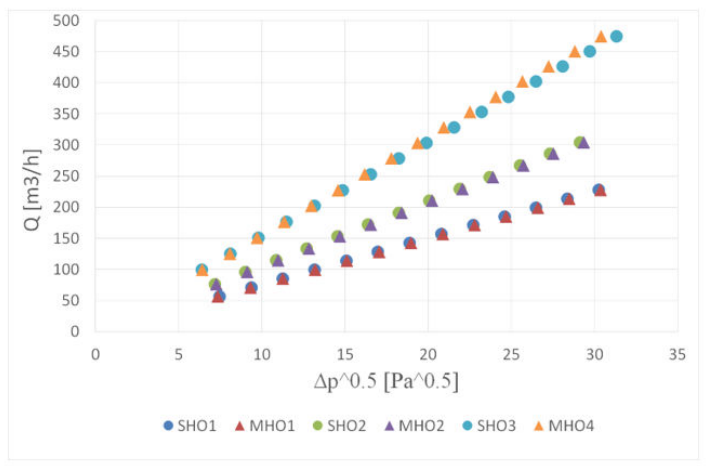
Figure 9. Volumetric flow rate versus pressure